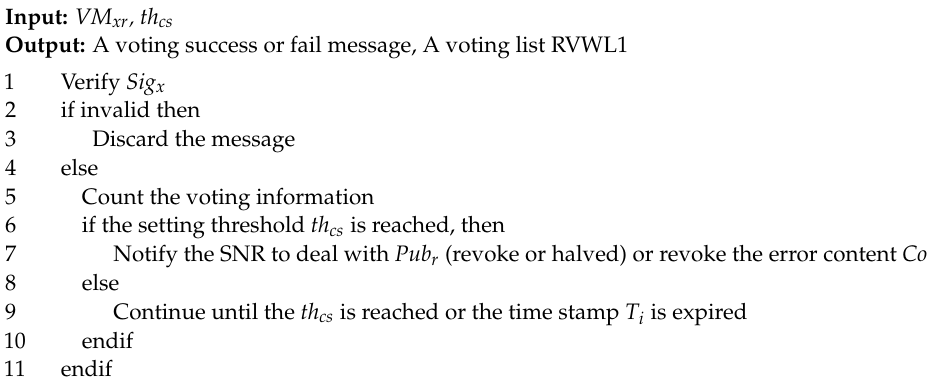
Algorithm 2 Voting information statistics of publisher E